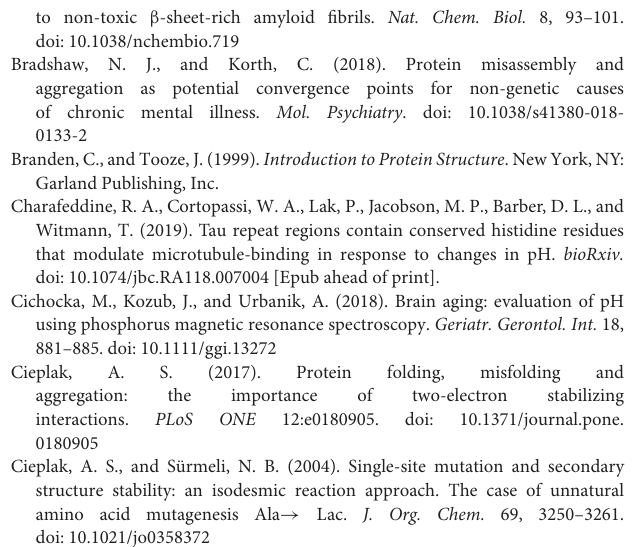
FIGURE 9 | MAP2c does not form PHFs, polymerization stops at the stage of granular aggregates. The green and red arrows point to the retained and altered, respectively, secondary structure assignments; note the marked increase in the “C 5 strand” propensity in the segment corresponding to the V306-K321 segment of R3, see the text. (B) (a) The FP i plot for 3R tau-TKKI mutant, see the text, and the anticipated secondary structure propensity in water. The right-hand diagram compares the superposed FP i profiles of PHF6 in WT and mutant protein. The adjacent plot of the ThT fluorescence intensity vs. time (blue curve) and the insert show that the mutant does not form PHFs; (b) The FP i plot for MAP2c-YKPV mutant, see the text, and the anticipated secondary structure propensity in water. The right-hand diagram compares the superposed FP i profiles of the PHF6-like segment in WT and mutant protein. The adjacent plot of ThT fluorescence intensity vs. time (red curve) and the insert show the assembly of fibrils, viz. the white arrows in the insert; (c) The FP i vs. 1 FP i − 1 → i + 1 plots for MAP2c and the MAP2c-YKPV mutant, note the shift in the “C 5 strand” propensity, up from the FP i region characteristic for PHF6 mutants that form granular aggregates, Figure 6C , to the region characteristic for PHF6 mutants that form wild-type filaments, Figure 6A ; (d) The anticipated “productive” homodimer of the MAP2c-YKPV